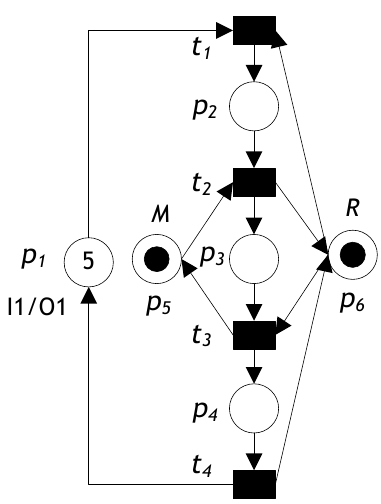
Figure 1. ( a ) Automated manufacturing system (AMS) example and ( b ) operation sequence.